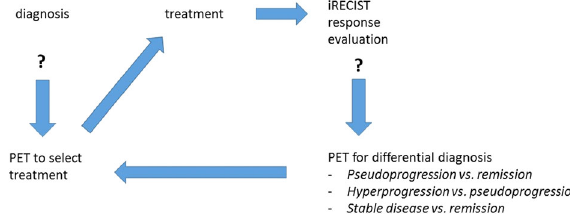
Fig. 2 The patient journey: PET in precision medicine. After the diagnosis has been established, PET will help select the optimal treatment to the patient. During the course of the treatment, several questions may arise, which cannot be solved by IRECIST. Here, PET may be indicated to answer speci fi c